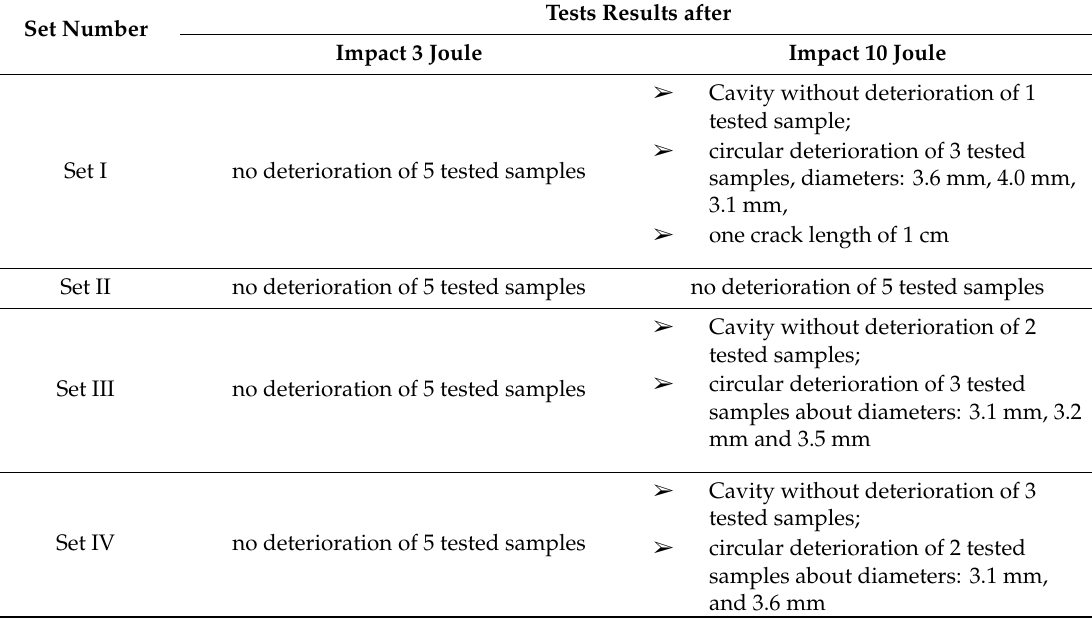
Table 2. Results of hard body impact resistance test, according to ETAG 004 / 2013